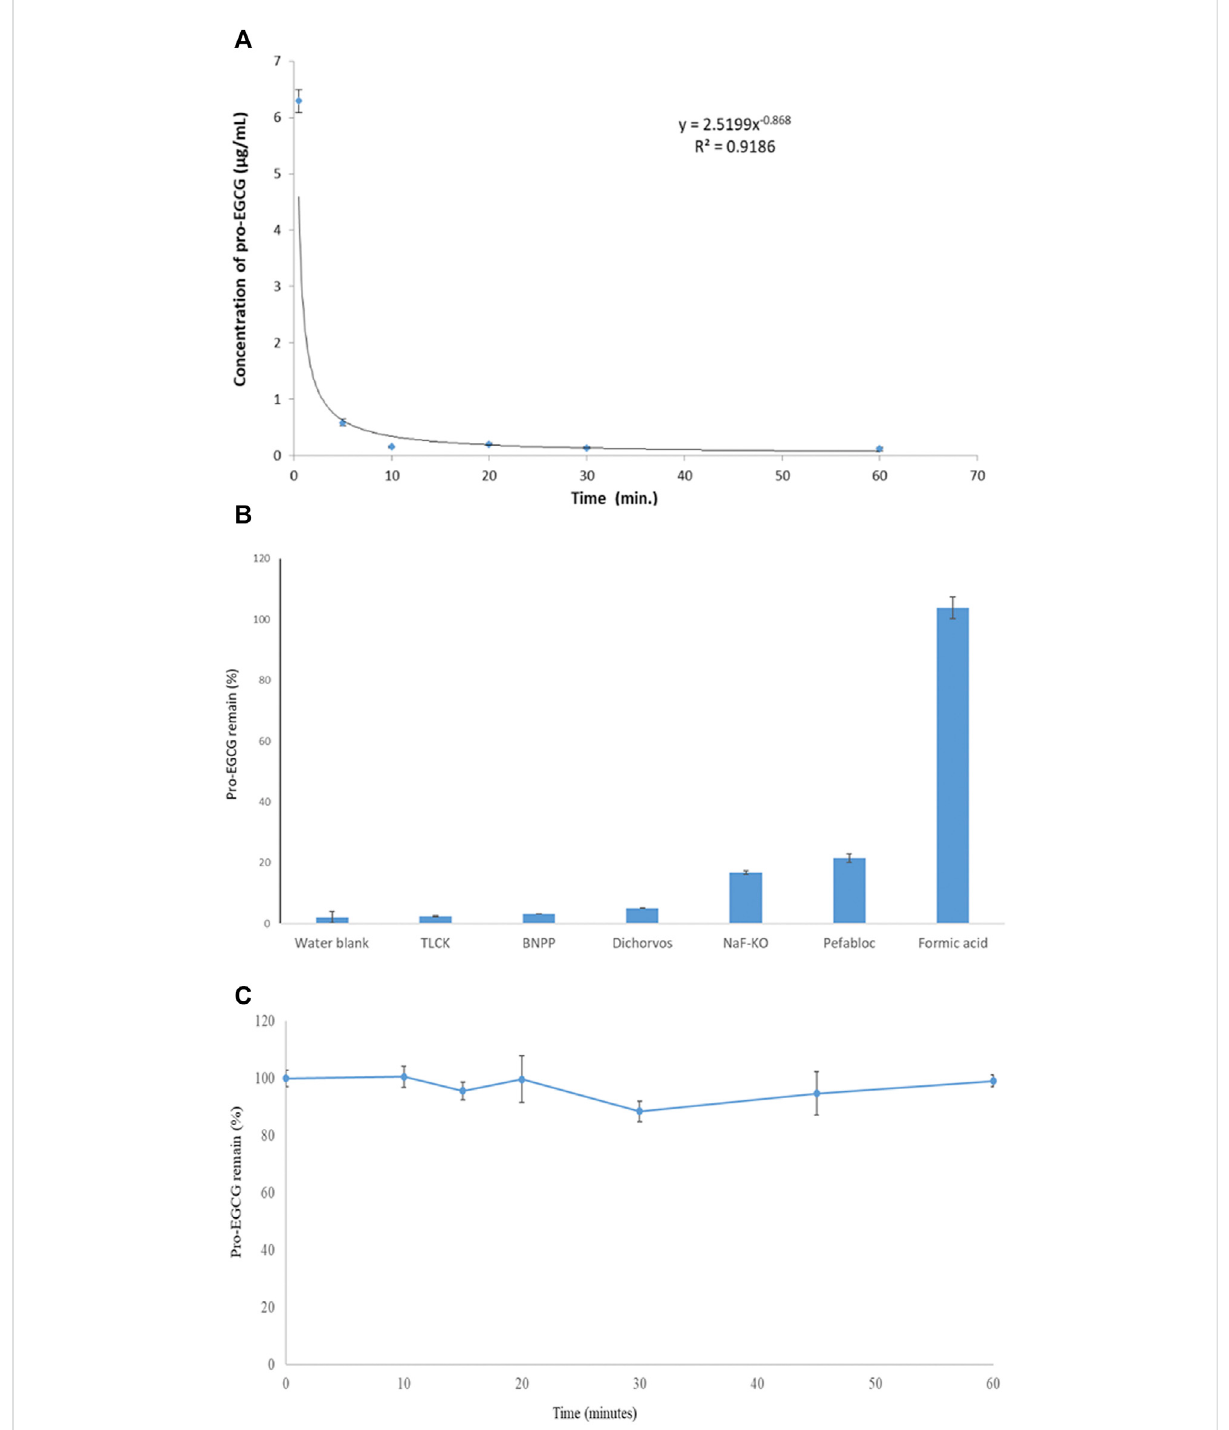
FIGURE 3 Stability of pro-EGCG in plasma. Diagrams showed (A) 50 μ g/mL of pro-EGCG was rapidly degraded in vitro in plasma ( n = 6) at room temperature. (B) the percentages of ef fi ciency of inhibition of different esterase inhibitors TLCK, BNPP, dichlorvos, and pefabloc, at 30 mM in a mixture ofNaF andKO (10 mg/mland 8 mg/mL) andformic acid at107 μ L/mL for degradationofpro-EGCG in10 min in an icebath. (C) 6 µL formic acid mixed with 50 µL plasma (about 107 µL formic acid per mL of the mixture) ( n = 3) to inhibit pro-EGCG degradation in ice (-10 ° C) over 60 min. Each point was mean ±